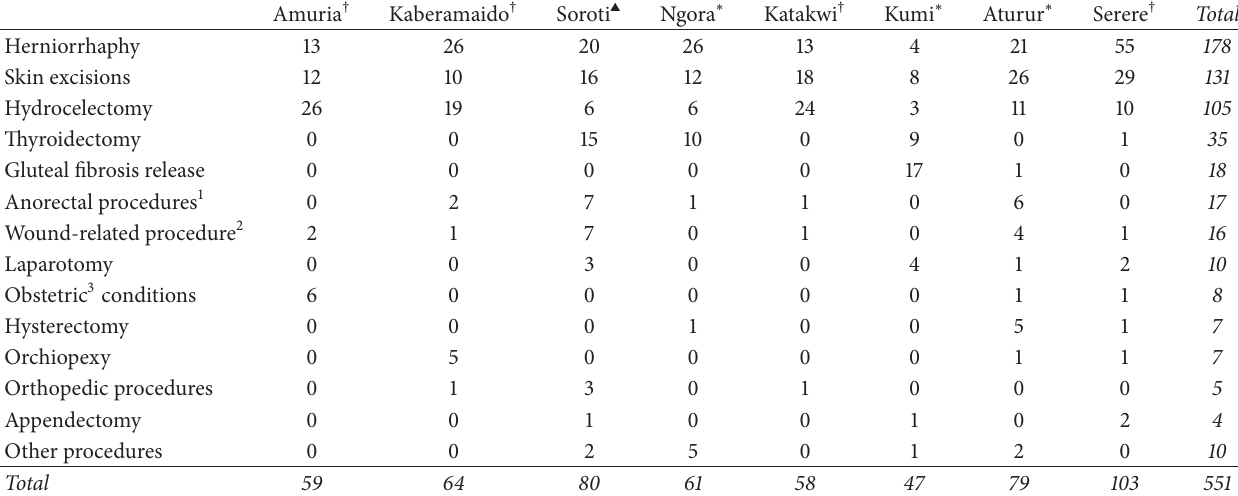
Table 1: Surgical procedures at a campsite in Uganda, 2013.